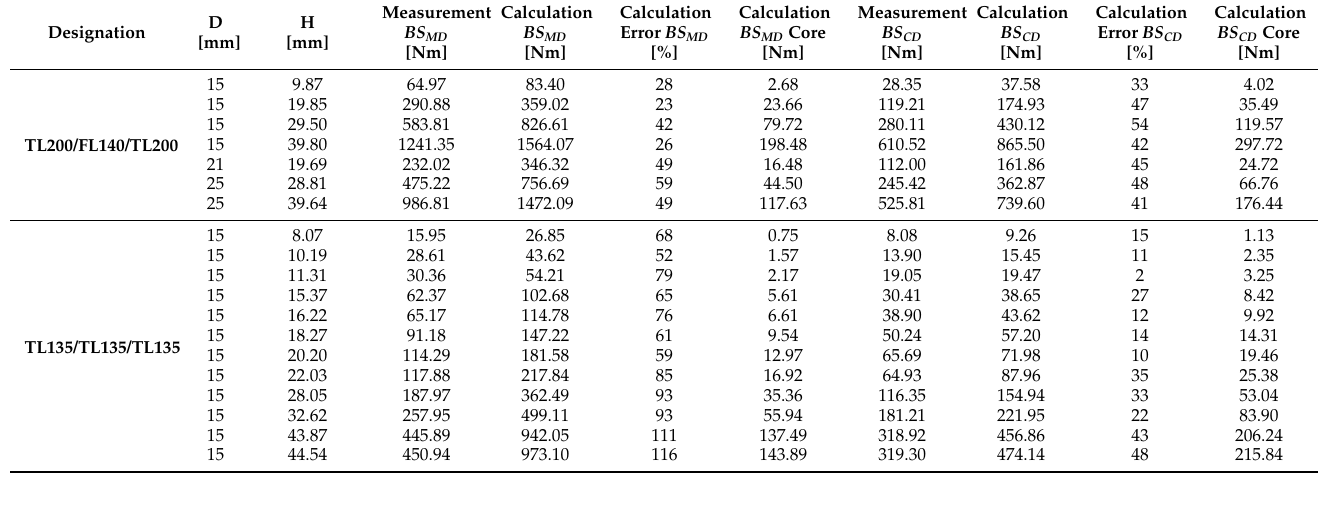
Table 3. Results of BS measurements and calculations using method I and calculation error.